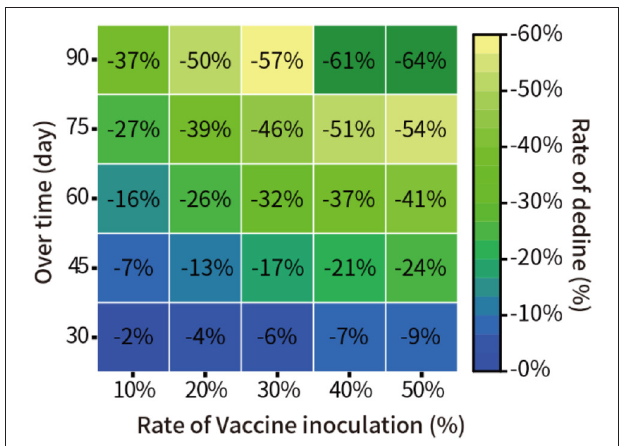
FIGURE 5 | Prediction of the pandemic under different vaccination rates in New York.